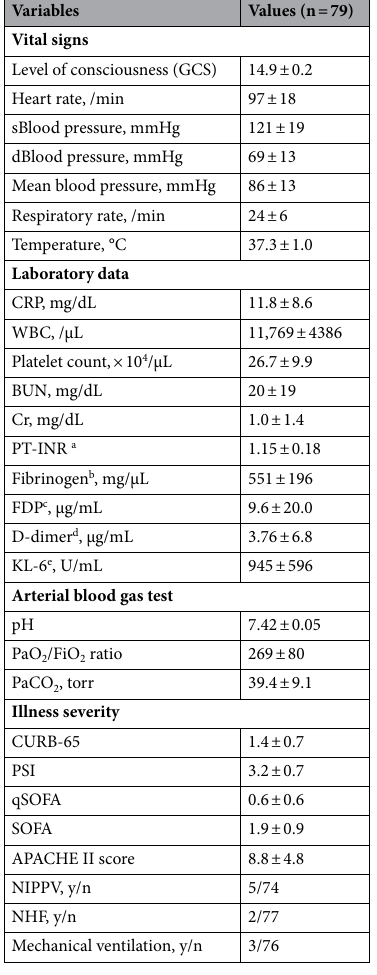
Table 2. Patient clinical data at the first hospitalization. Values are expressed as mean ± standard deviation or actual number. APACHE II Acute Physiology and Chronic Health Evaluation II; BUN, blood urea nitrogen; Cr creatinine; CRP C-reactive protein; CURB-65 confusion, urea, respiratory rate, blood pressure and age score; FDP fibrinogen and fibrin degradation products; GCS Glasgow coma scale; KL-6 Krebs von der Lungen-6; NHF nasal high flow; NIPPV noninvasive positive pressure ventilation; PaCO 2 partial pressure of carbon dioxide; PaO 2 /FiO 2 partial pressure of atrial oxygen / fraction of inspiratory oxygen; PSI Pneumonia Severity Index; PT INR prothrombin tome-international normalized ratio; qSOFA quick Sequential Organ Failure Assessment; SOFA sequential organ failure assessment; WBC white blood cell. a n = 74; b n = 48; c n = 62; d n = 54; e n =